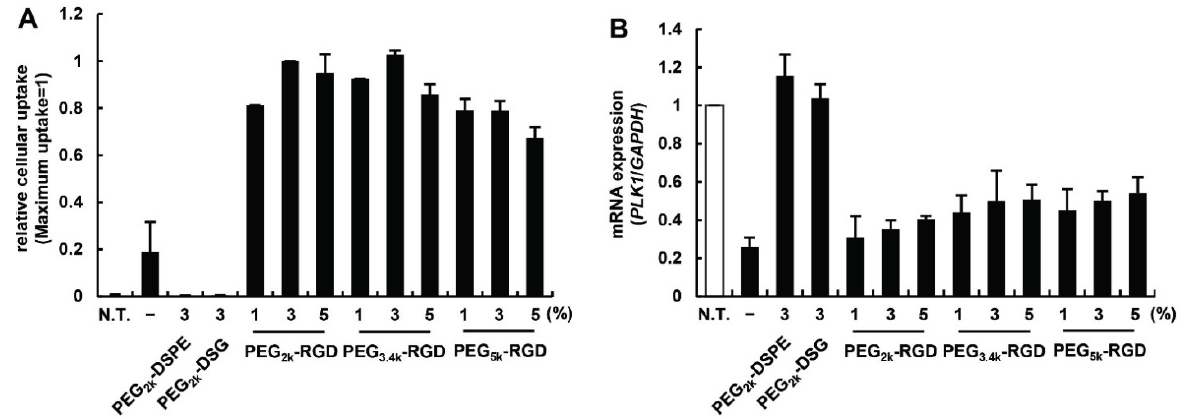
Figure 2. The effect of linker derivatives on the in vivo siRNA delivery. ( A ) The effect of the length of the PEG-linker and the density of RGD PEG-lipids on the uptake of MENDs. The cellular uptakes of RGD-MENDs were measured by FCM 2 h after the transfection of fluorescently labeled MENDs. Data represents mean ± S.D. ( n = 3). ( B ) The effect of the linker length and density on the gene silencing efficiency of MENDs. Gene silencing was evaluated as a decrease of polo-like kinase 1 ( PLK1 ) mRNA level estimated with qRT-PCR. Data represents mean ± S.D. ( n =